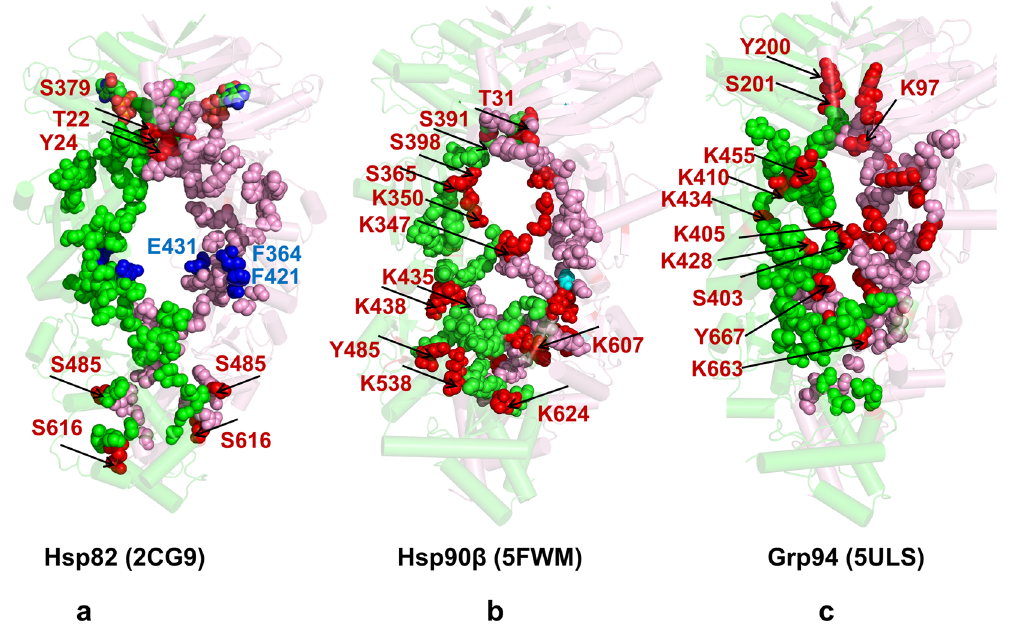
Figure 9. Structural Maps of Allosteric Communication Pathways between Major Effector and Sensor Centers in the Hsp90 Proteins. Structural map of major communication pathways connecting major effector and sensor centers through high centrality edges in the closed dimer forms of yeast Hsp82 ( a ), human Hsp90 β ( b ), and canine Grp94 ( c ). The Hsp90 structures are shown in ribbons with reduced transparency to enhance clarity of communication paths. The monomer A is shown in green ribbons and monomer B in pink ribbons. The depicted pathways represent most probable routes that connect effector centers in the Hsp90-NTD with sensor sites in the Hsp90-CTD regions. Residues along these pathways are shown in green and pink spheres for respective monomers. The positions of PTM sites in the Hsp90 proteins are highlighted by red spheres and annotated. Note that conserved PTM sites can often assume role of high centrality bridges forming hubs in communication pathways. The position of experimentally known regulatory control points in the yeast Hsp82 chaperone 80 are shown on blue spheres and